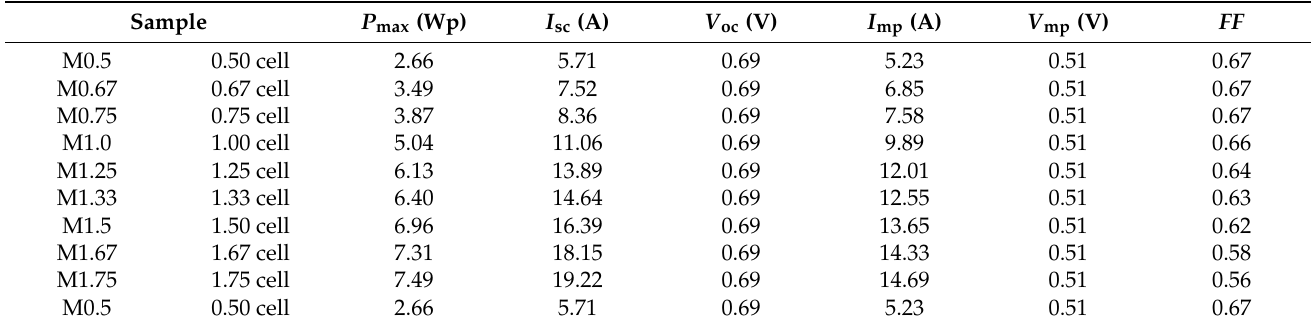
Table 8. Electrical characteristics of unit module samples.